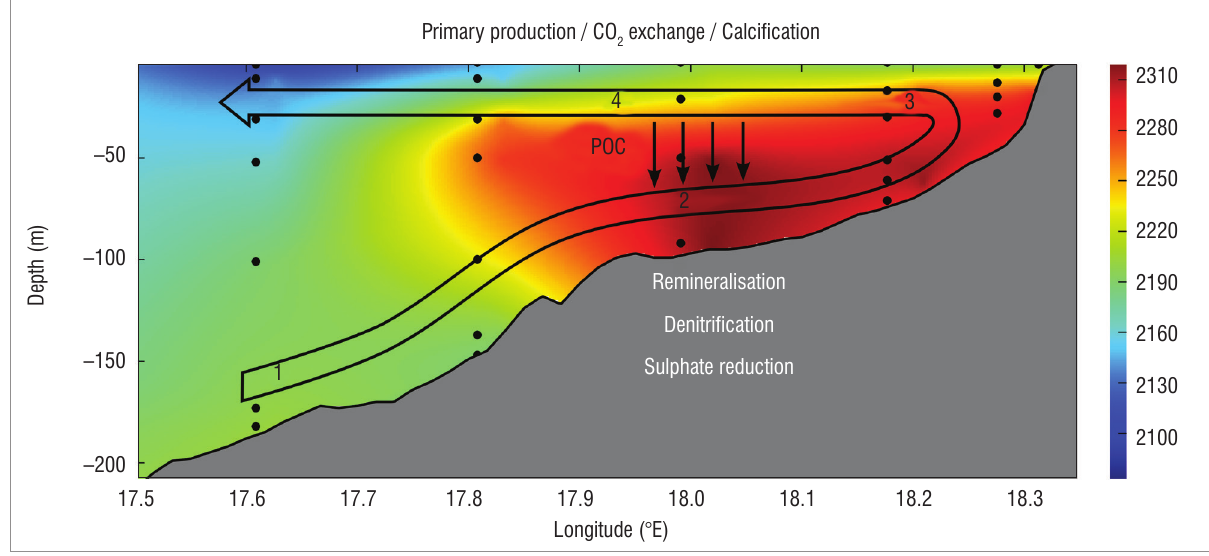
Figure 3: A vertical section of dissolved inorganic carbon (µmol/kg) for April 2010. The thick arrow shows the idealised cross-shelf flow driven by upwelling. The small arrows depict particulate organic carbon (POC) sinking. The surface processes that alter pCO above the plot and those that affect pCO in the ocean below are shown at the 2